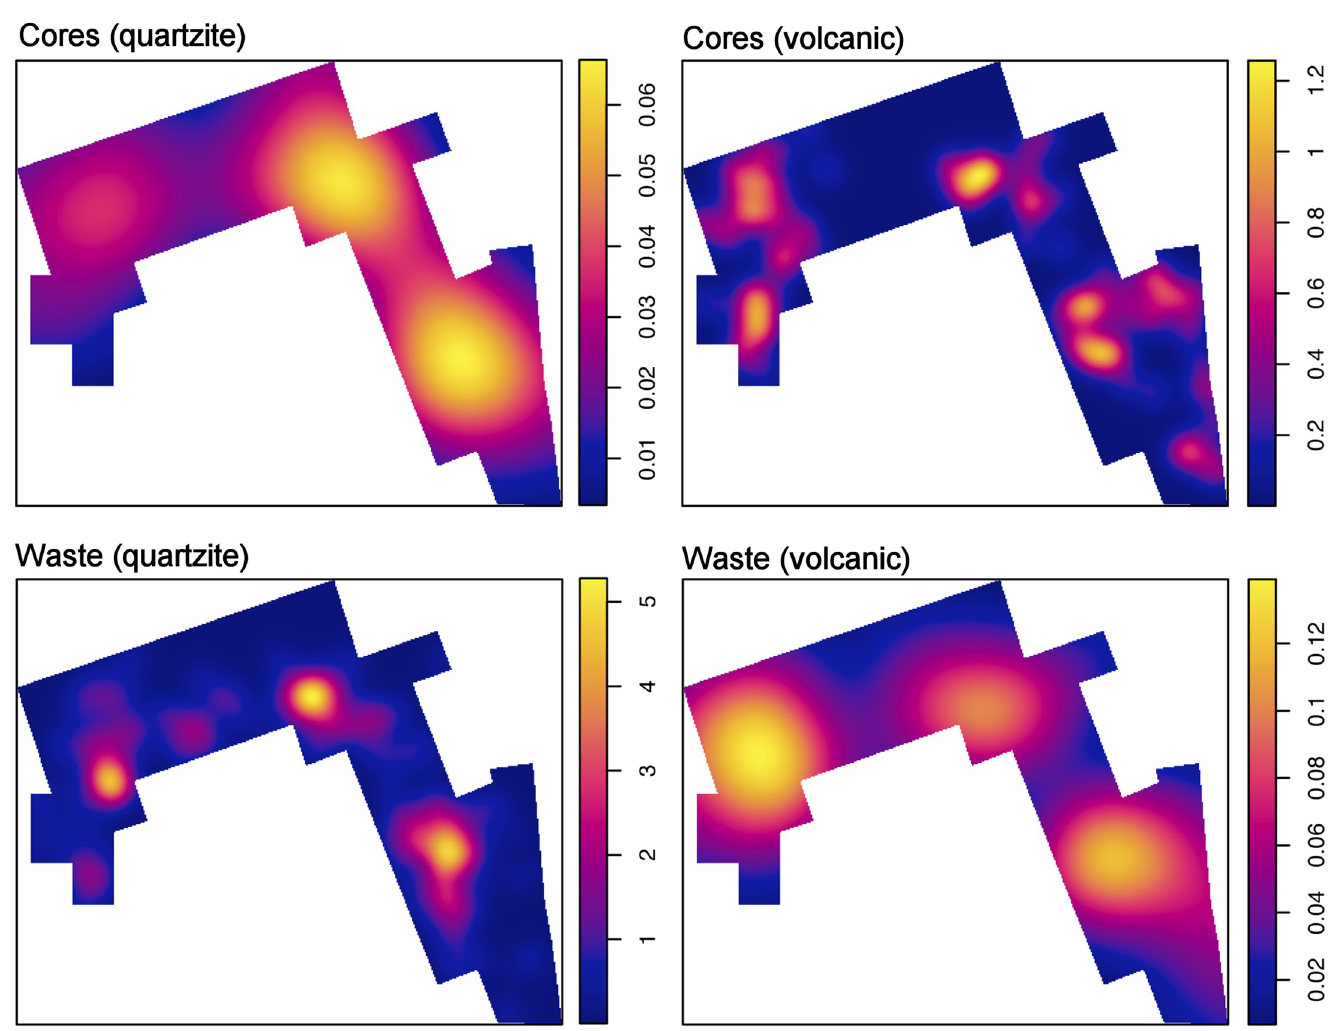
Fig 15. Density maps of freehand cores and by-products (waste) by raw material